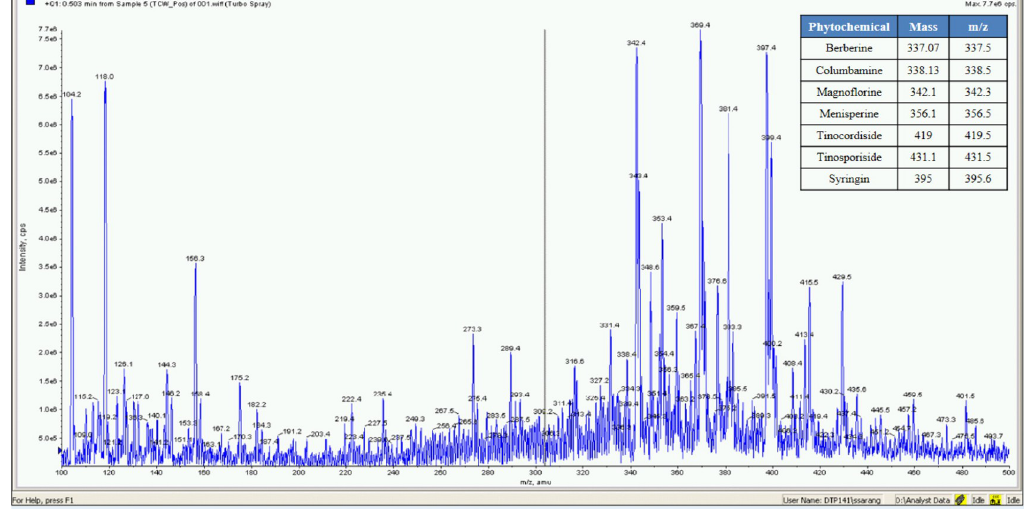
Fig 6. Mass spectrometer fingerprinting of Tinospora cordifolia water extract (TCW).